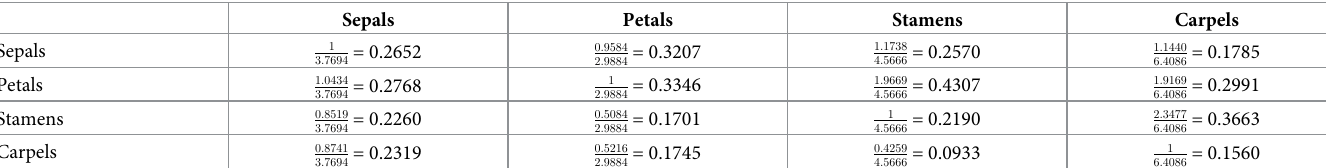
Table 4. A value divided by the sum.